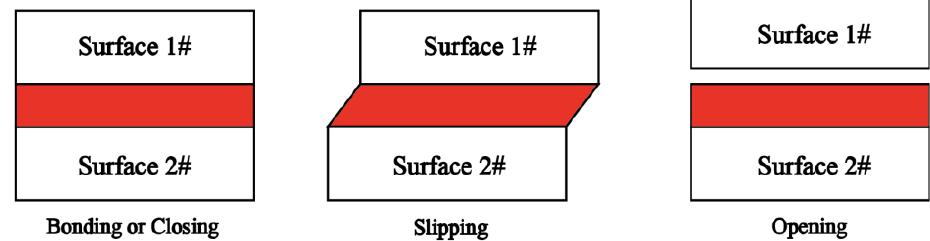
Figure 2. Contact surface behavior of pile – soil interaction.